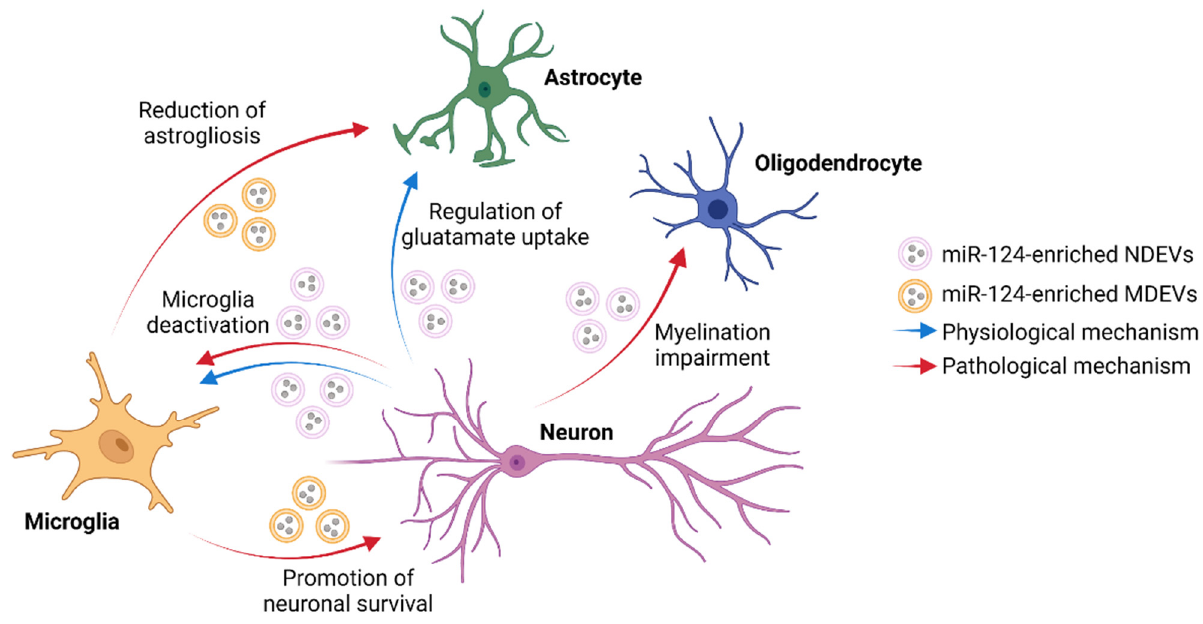
Figure 1. Schematic representation of the potential neuron-glia interactions mediated by vesicular exchange of miR-124 in both physiological and pathological conditions. NDEVs = neuron-derived EVs; MDEV = microglia-derived EVs. Created with BioRender.com.